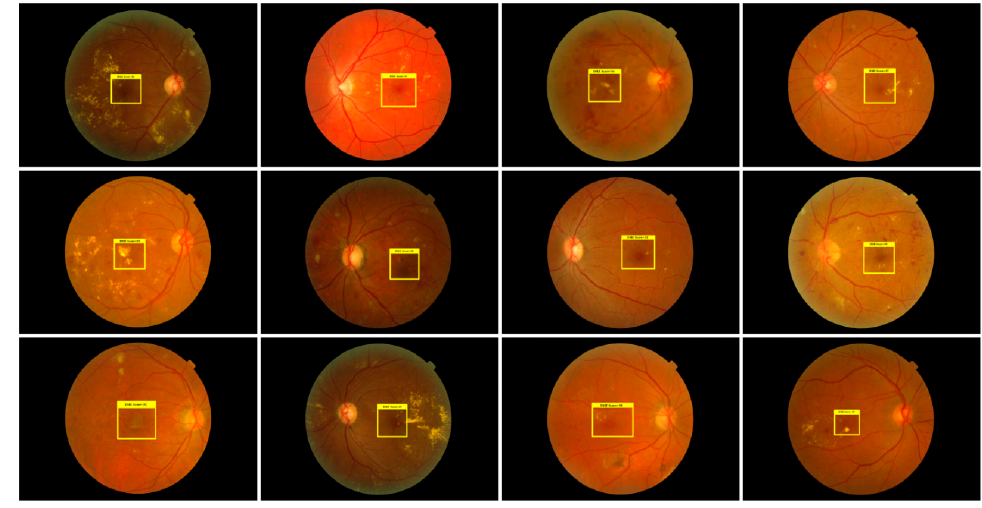
Figure 4. Test results of DME.